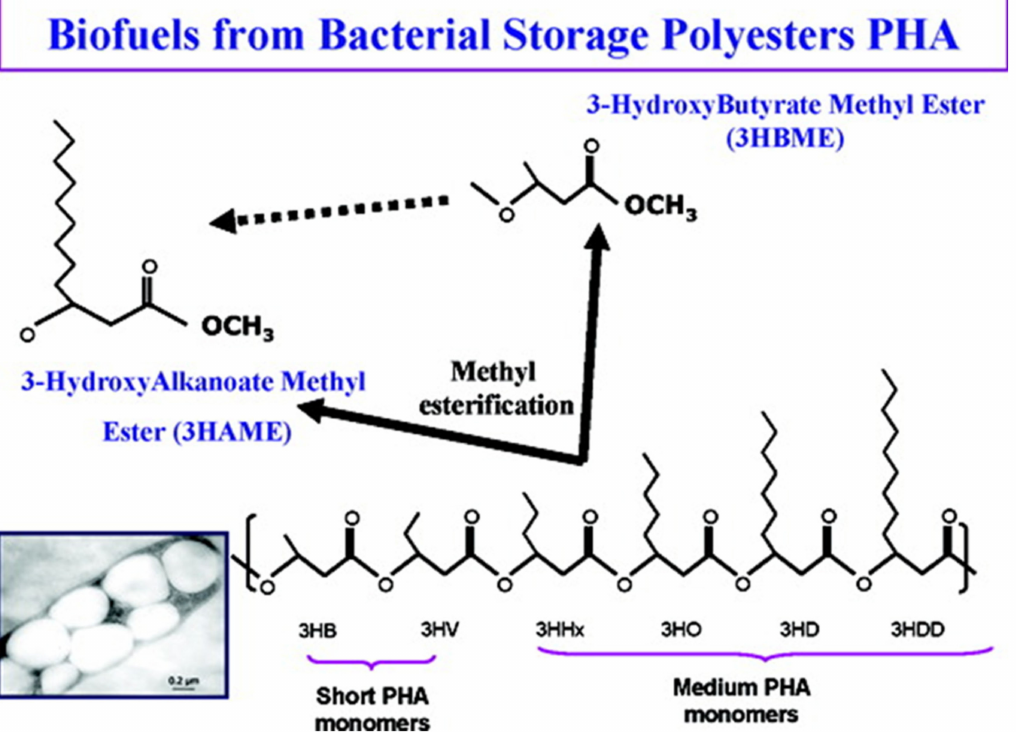
Figure 8. Methyl esterification of various PHA monomers to produce PHA-based biofuels. Reproduced with permission from [122]. Copyright 2009 American Chemical